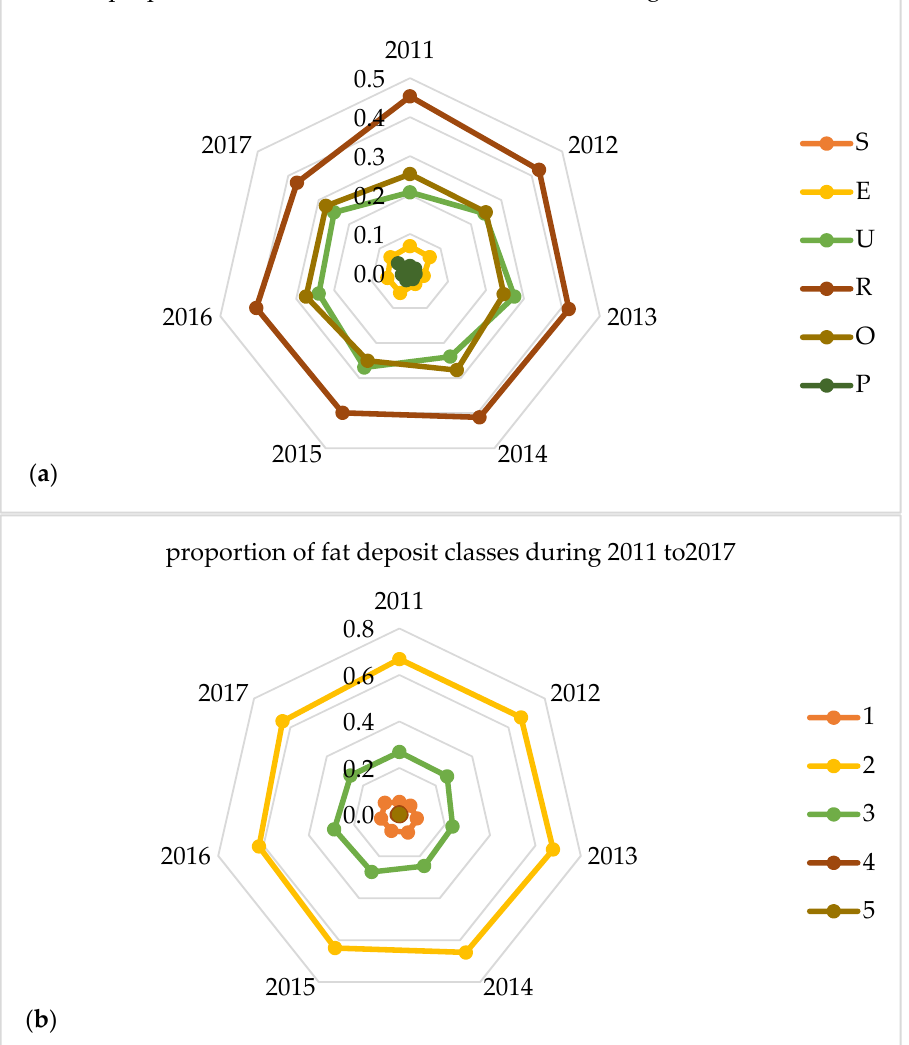
Figure 2. Proportion of muscle conformation ( a ) and fat deposit ( b ) classes for the carcasses during 2011–2017.